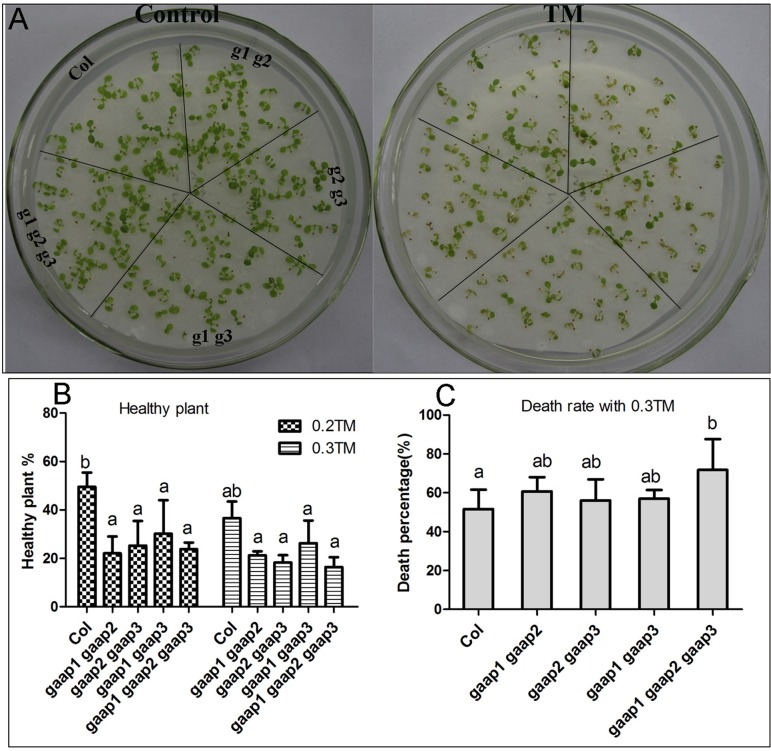
Plant sensitivity toward TM treatment increased with the increasing mutant gene number of GAAP1, GAAP2 and GAAP3. (A) The growth of Col, gaap1gaap2, gaap2gaap3, gaap1gaap3 and gaap1gaap2gaap3 seedlings on 1/2 MS medium for 3 days and then transferred on 1/2 MS medium supplied with 0–0.20 μg ml−1 TM for another 6 d. (B–C). Healthy plant (B) and death rates (C) of seedlings, which were treated with 0.2 and 0.3 μg ml−1 TM for 6 days. Error bars depict the standard error of four independent experiments, and different letters indicate significant differences between different plants subjected to χ test (*p < 0.05, n > 100).